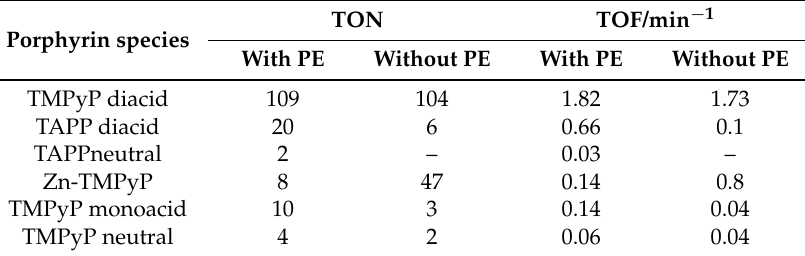
Table 4. Corresponding TON/TOF of investigated porphyrin-polyelectrolyte assemblies.